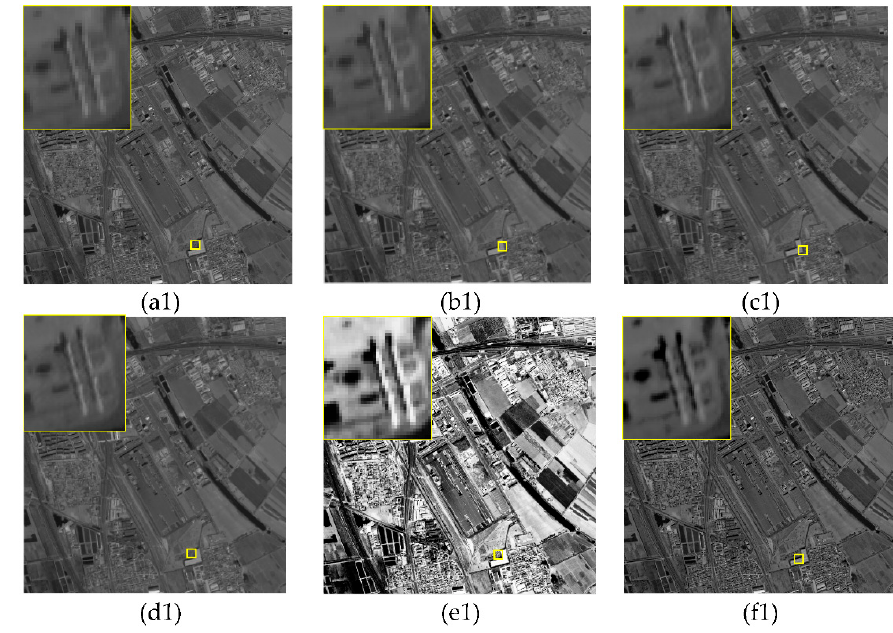
Figure 6. Experimental images ( a ) ZY-3 panchromatic image; ( b ) GF-2 panchromatic image; ( c